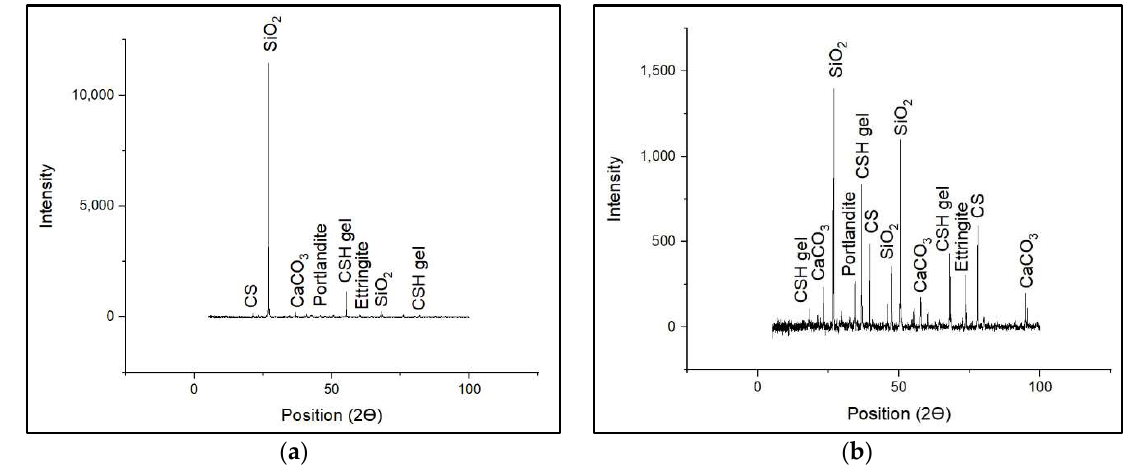
Figure 16. XRD results: ( a ) Conventional Concrete, ( b ) fibre reinforced concrete.